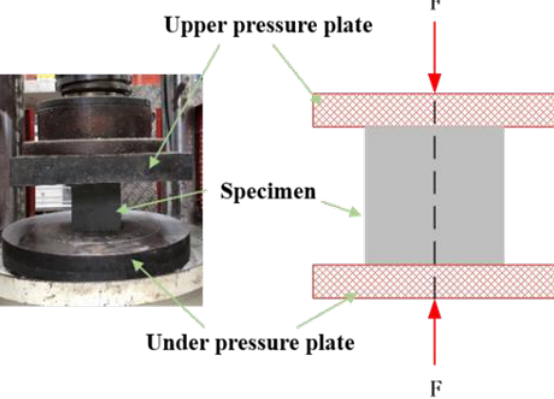
Figure 2. Compressive test of the cubic specimens.